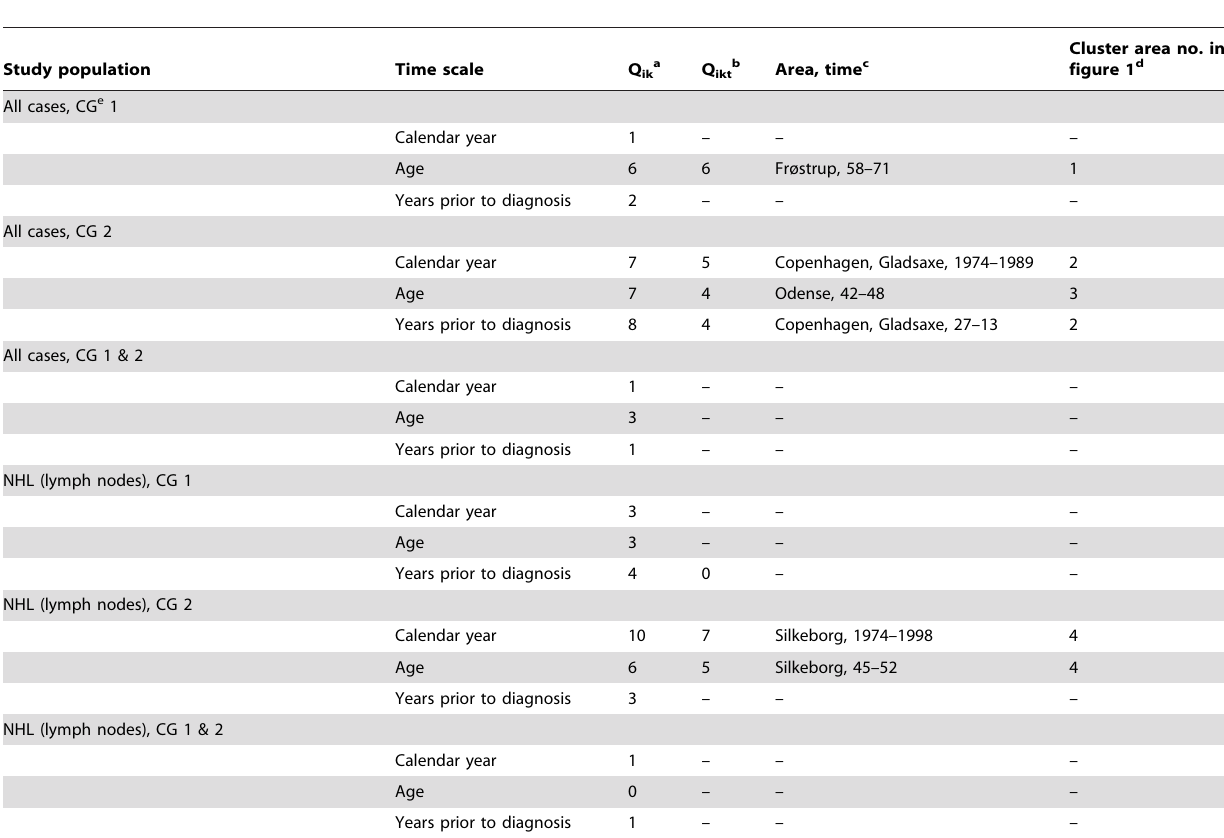
Table 1. Results of unadjusted space-time cluster analyses performed in SpaceStat, based on 15 nearest neighbours, 999 permutations, and by three different time